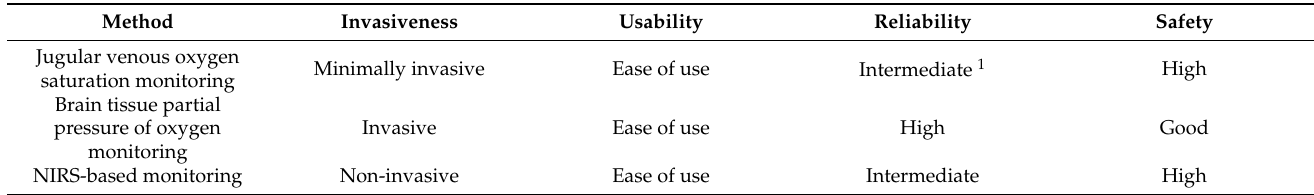
Table 2. Overall features of different methods.